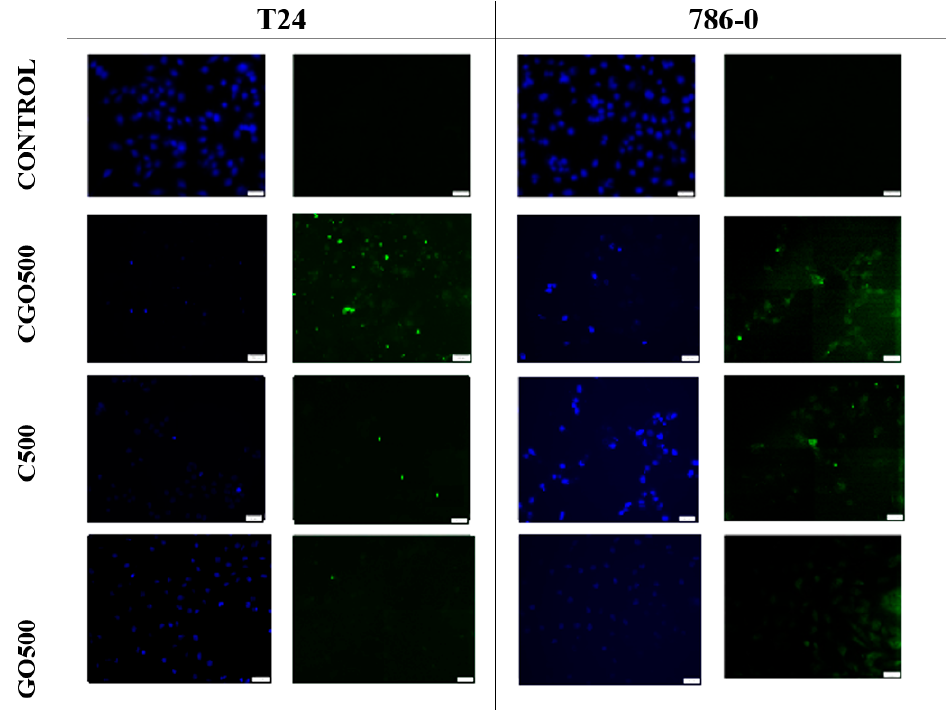
Figure 8. Cells of the 786-0 and T24 lines showing the results of the active caspase 3/7 assay. DAPI-stained cell nucleus, FITC—cells that underwent apoptosis. The photos were taken with the CKX53 FN Olympus fluorescence microscope, Japan, and the VC90 4 K Olympus camera, Japan. For the test samples with graphene oxide, autofluorescence of the compound itself was observed, which significantly hindered the observation of apoptotic cells. Scale bar is 50 μ m.